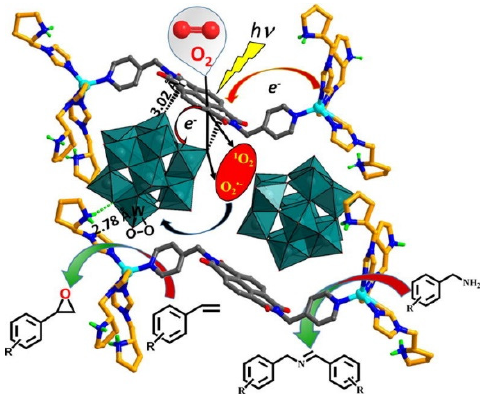
Figure 16. Zn-DPNDI-PYI as photocatalyst for the coupling of primary amines and oxidation of olefins with air under visible light. Reprinted from [149]. Copyright (2019), with permission from